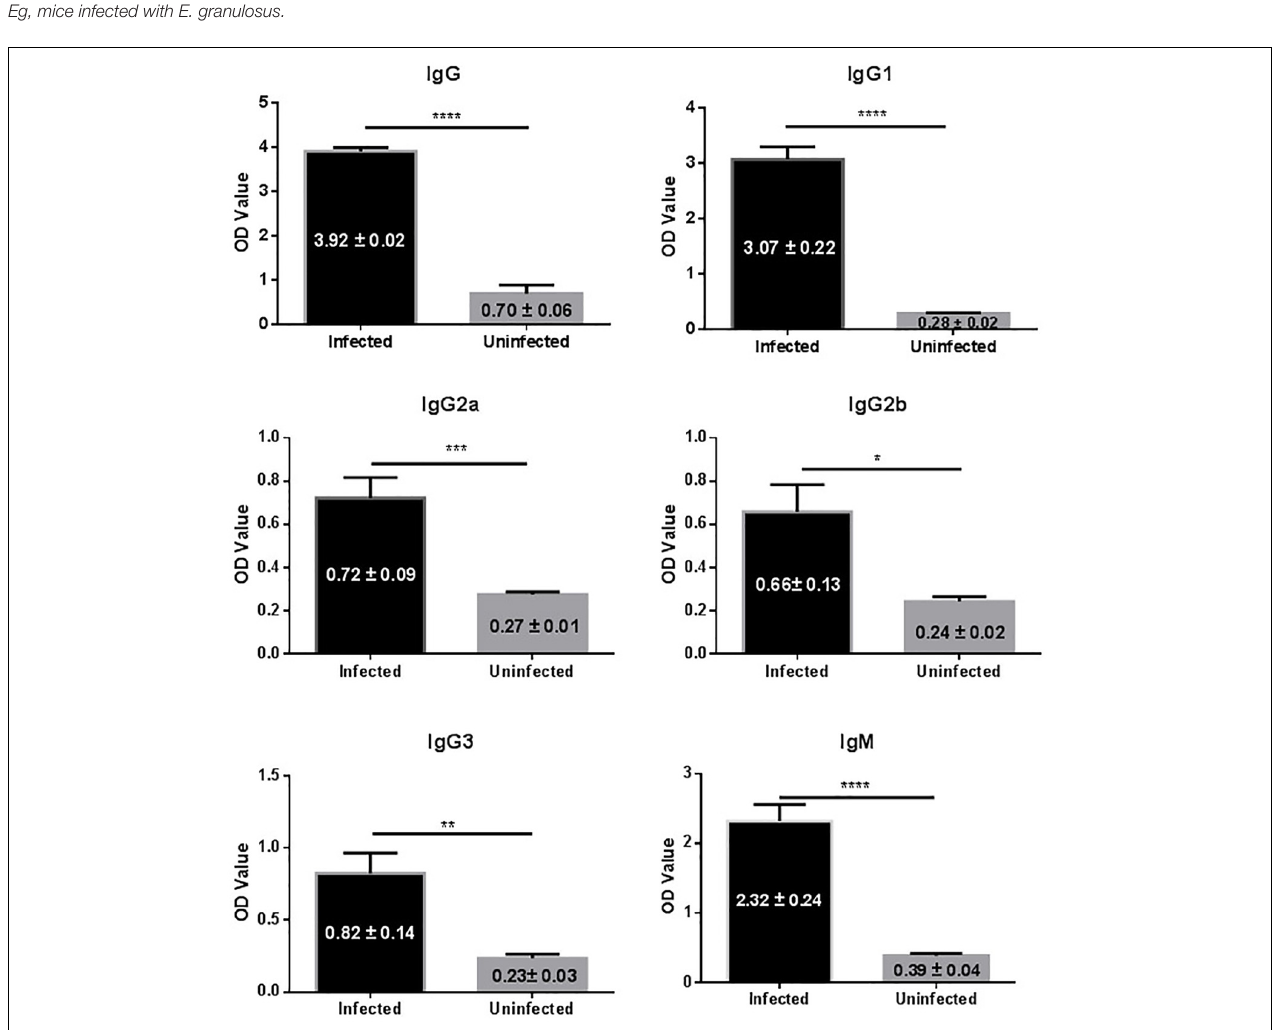
FIGURE 1 | IgG antibody isotypes and subtypes in sera of mice infected with E. granulosus . ∗ p < 0.05, ∗∗ p < 0.01, ∗∗∗ p < 0.005, ∗∗∗∗ p <